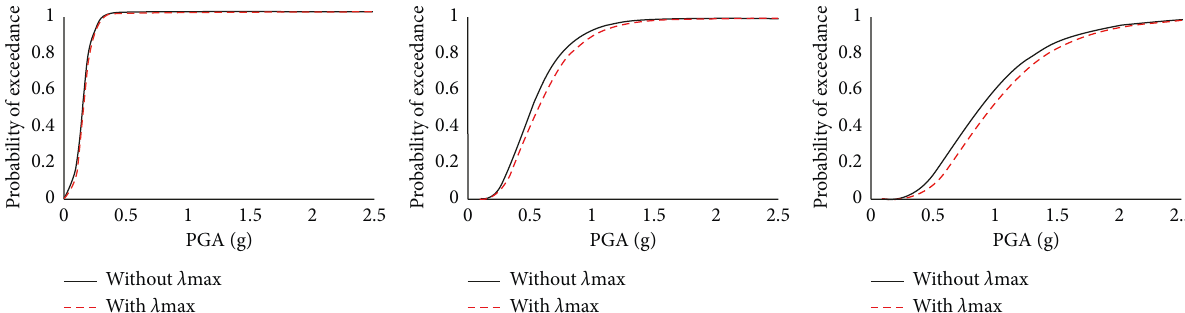
Figure 11: Comparison of λ max factor influence on TFPBs friction bearings’ performance for the squat tank. (a) SLE. (b) DBE. (c)